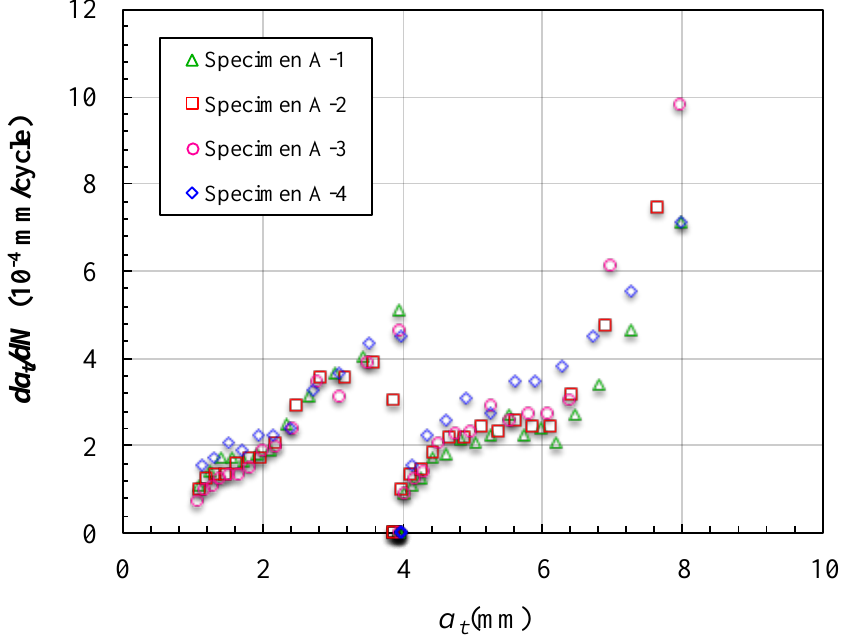
Figure 13. FCG rate at different crack lengths a t of specimens of Group